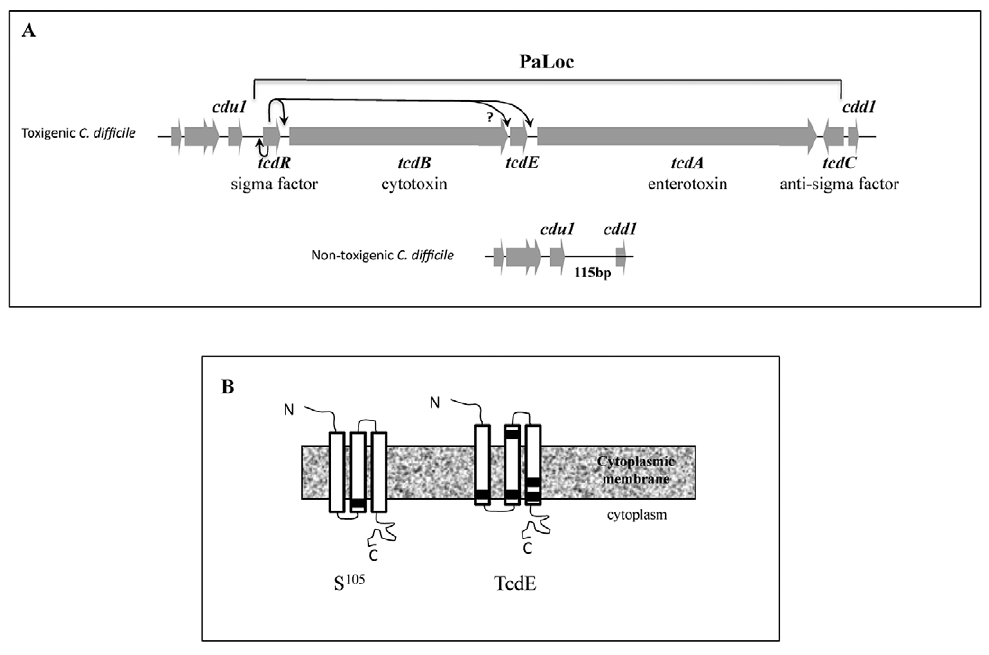
Figure 1. PaLoc in C.difficile . A. Schematic diagram of PaLoc in toxigenic C. difficile strains. In non-toxigenic strains this region is replaced by a short 115 bp sequence. Arrows indicates the positive regulation of tcdR , tcdB and tcdA by s TcdR . B Predicted topology of TcdE and. l S holin Horizontal black bars represent the relative position of Cys 51 in S 105 and Cys 29, 56, 79, 111 and 113 in TcdE.